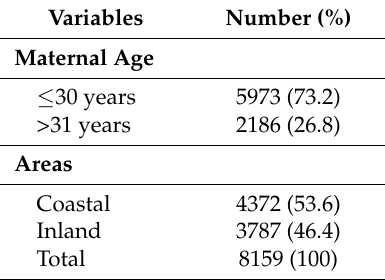
Table 2. Number of the total study population of pregnant women by maternal age and